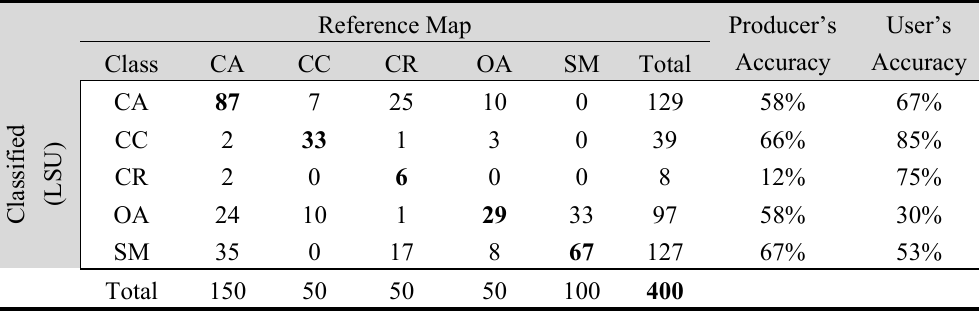
Table 4. Error matrix of LSU classified map versus reference map.